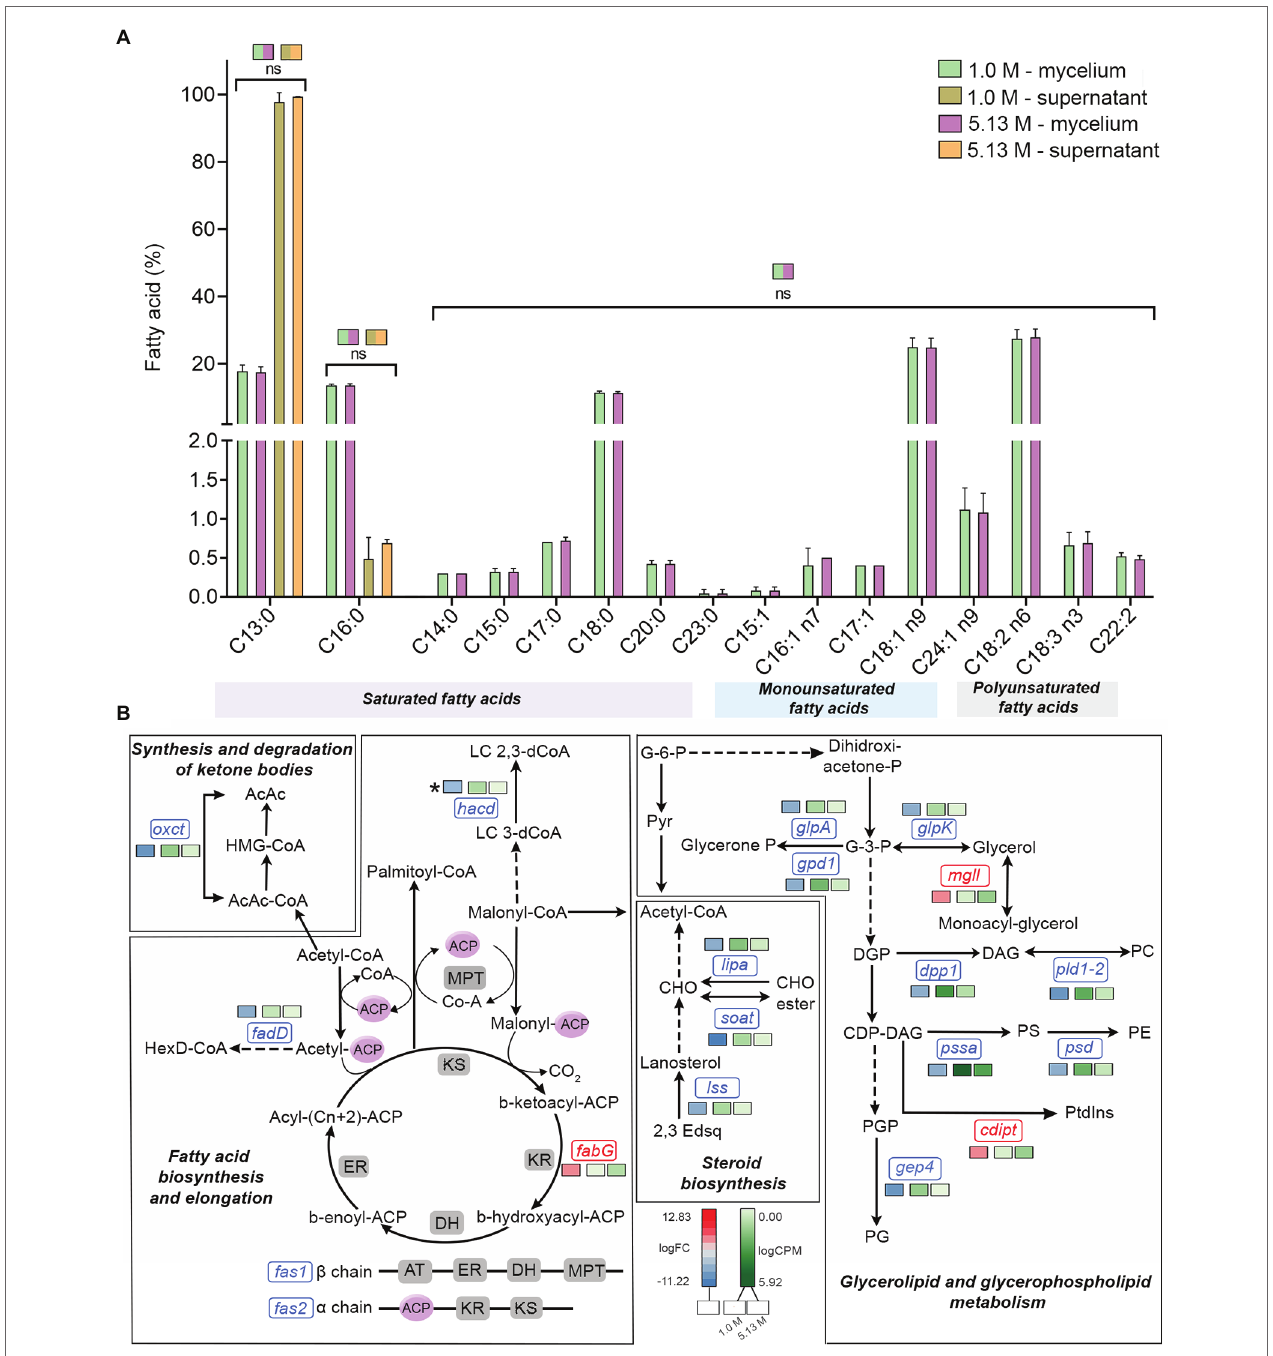
FIGURE 3 | Quantitative profile of fatty acids and differential expression of genes related to fatty acid metabolism in A. sydowii exposed to 5.13 M NaCl compared to 1 M NaCl. (A) Bar chart showing the percentage of saturated (C13:0–C23:0), monounsaturated (C15:1–C24:1 n9), and polyunsaturated (C18:2 n6–C22:2) in both mycelia and supernatants collected from fungal cultures at 1 M and 5.13 M NaCl. In (B) the statistics shown refer to the comparisons that were not statistically significant (ns); thus, the rest of the comparisons are statistically significant. (B) Metabolic map showing differentially expressed genes involved in fatty acid biosynthesis pathways in A. sydowii cultured at 5.13 M NaCl compared to 1 M NaCl. Red and blue boxes/letters indicate genes upregulated (logFC > 1.5) and downregulated (logFC < − 1.5), respectively. Asterisks indicate that two or more transcript isoforms were identified for that gene. The three squares above each gene box illustrate the logFC values and CPM of transcripts in each salt concentration. Dashed and continuous lines refer to intermediate and direct reactions, respectively. AcAc, acetoacetyl-CoA; HMG-CoA, S-3-hydroxy-3-methylglutaryl-CoA; HexD-CoA, hexadecanoyl-CoA; LC 2,3-dCoA, long-chain trans-2,3-dehydroacyl-CoA; LC 3-dCoA, long-chain-3-hydroxyacyl-CoA; G-6-P, glucose-6-phosphate; Pyr, pyruvate; CHO, cholesterol; 2,3-Edsq, S-squalene; G-3-P, glycerol-3-phosphate; DGP, 1,2-diacyl-glycerol-3P; DAG, 1,2-diacyl-glycerol; CDP-DAG, CDP-diacylglycerol; PGP, phosphatidyl-glycerophosphate; PG, phosphatidylglycerol; PC, phosphatidylcholine; PE, phosphatidylethanolamine; PS, phosphatidylserine; Ptdlns, phosphatidyl-1D-myo- inositol; ACP, acyl carrier protein; ER, β -enoyl reductase; DH, dehydratase; KR, β -ketoacyl reductase; KS, β -ketoacyl synthase; and MPT, malonyl/palmitoyl